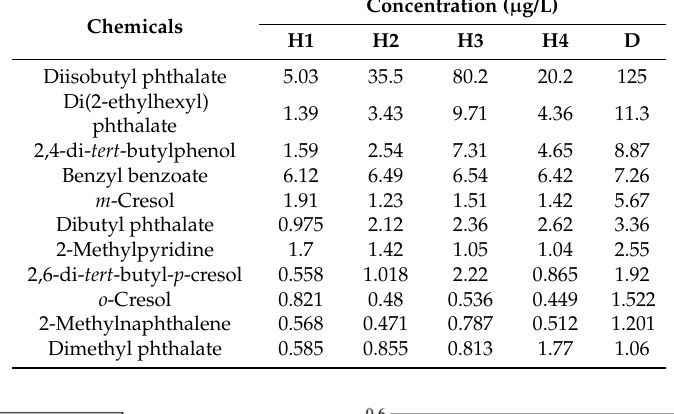
Table 2. Concentrations of organic chemicals in surface water samples.